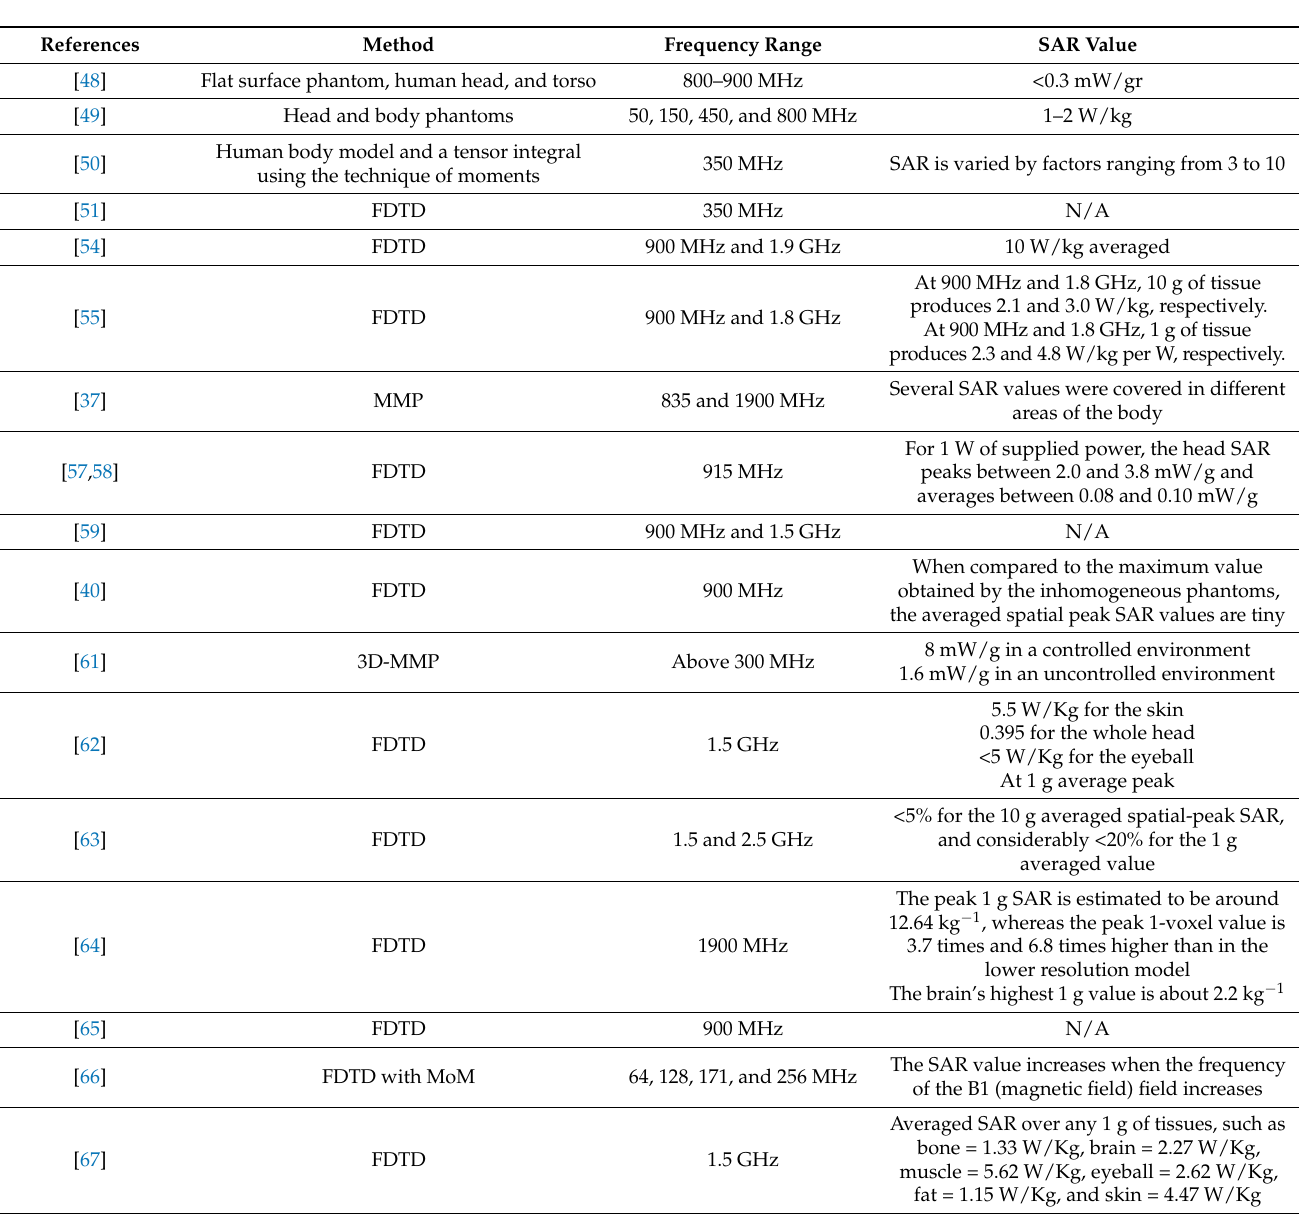
Figure 13. The proposed 2 × 2 MIMO configuration for smartphones: ( a ) MIMO array with LCD and hand phantom, ( b ) AR values at 3.5 GHz [118]. Table 2. Summaries of all the techniques utilised between 1978 and 2021, including the frequency bandwidth and SAR